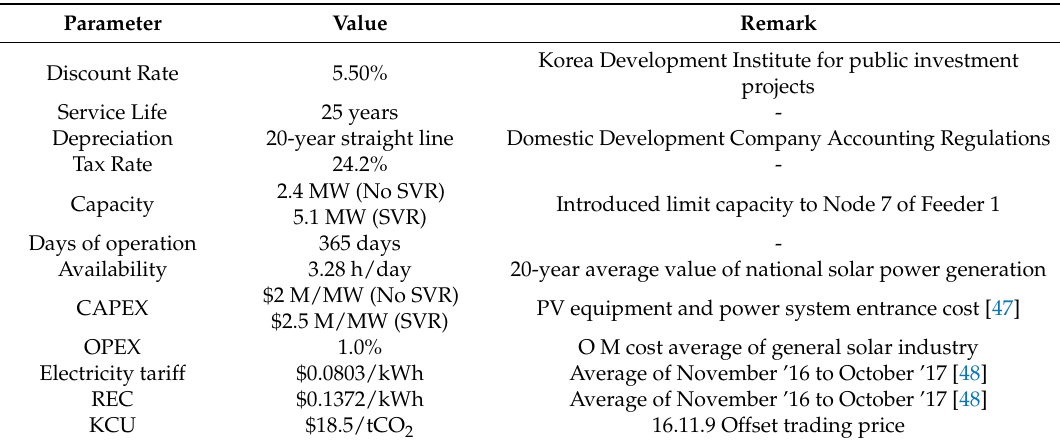
Table 3. Key economic